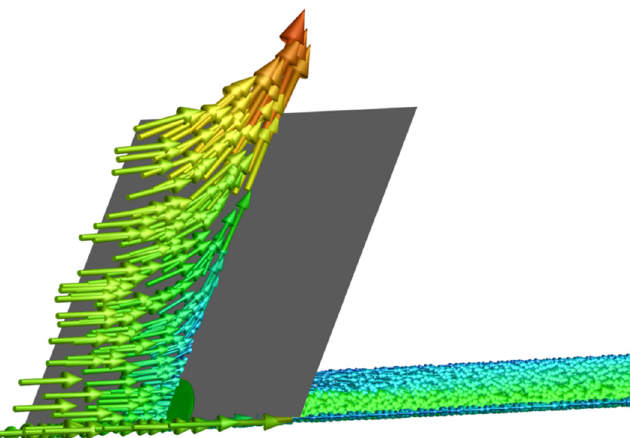
Figure 8. Wind blowing at the windward portal of the modeled tunnel.